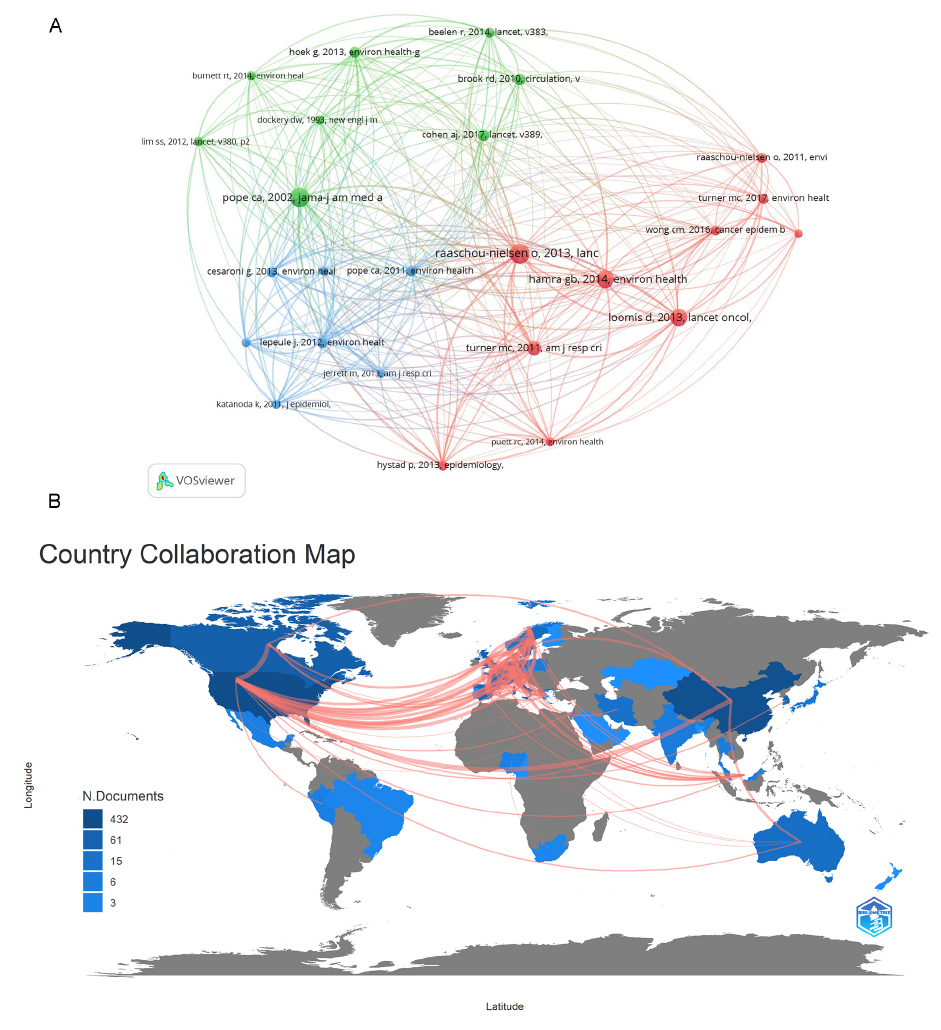
Figure 4. ( A ) Network visualization relations of articles cited 20 times or more. ( B ) Country collabo- ration map of the world. The red line represented the contact and cooperation between countries. The left corner of ( B ) showed the statistics of each author’s